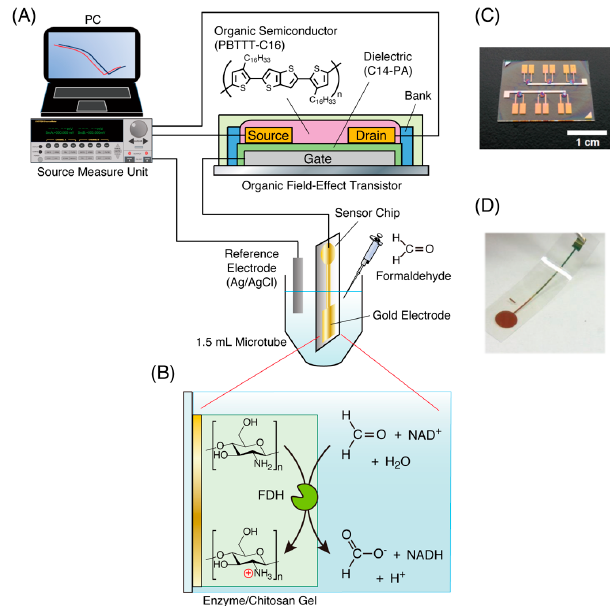
Figure 1. ( A ) Setup of an organic field-effect transistor (OFET)-sensor for a formaldehyde detection system using a polyethylene naphthalate (PEN) film sensor chip equipped with a gold electrode, on which the formaldehyde dehydrogenase (FDH)/chitosan gel was coated. ( B ) Schematic of the reaction process in the enzyme/chitosan gel on the sensor chip. ( C ) Photograph of six OFET devices on a plate. ( D ) Photograph of a sensor chip.